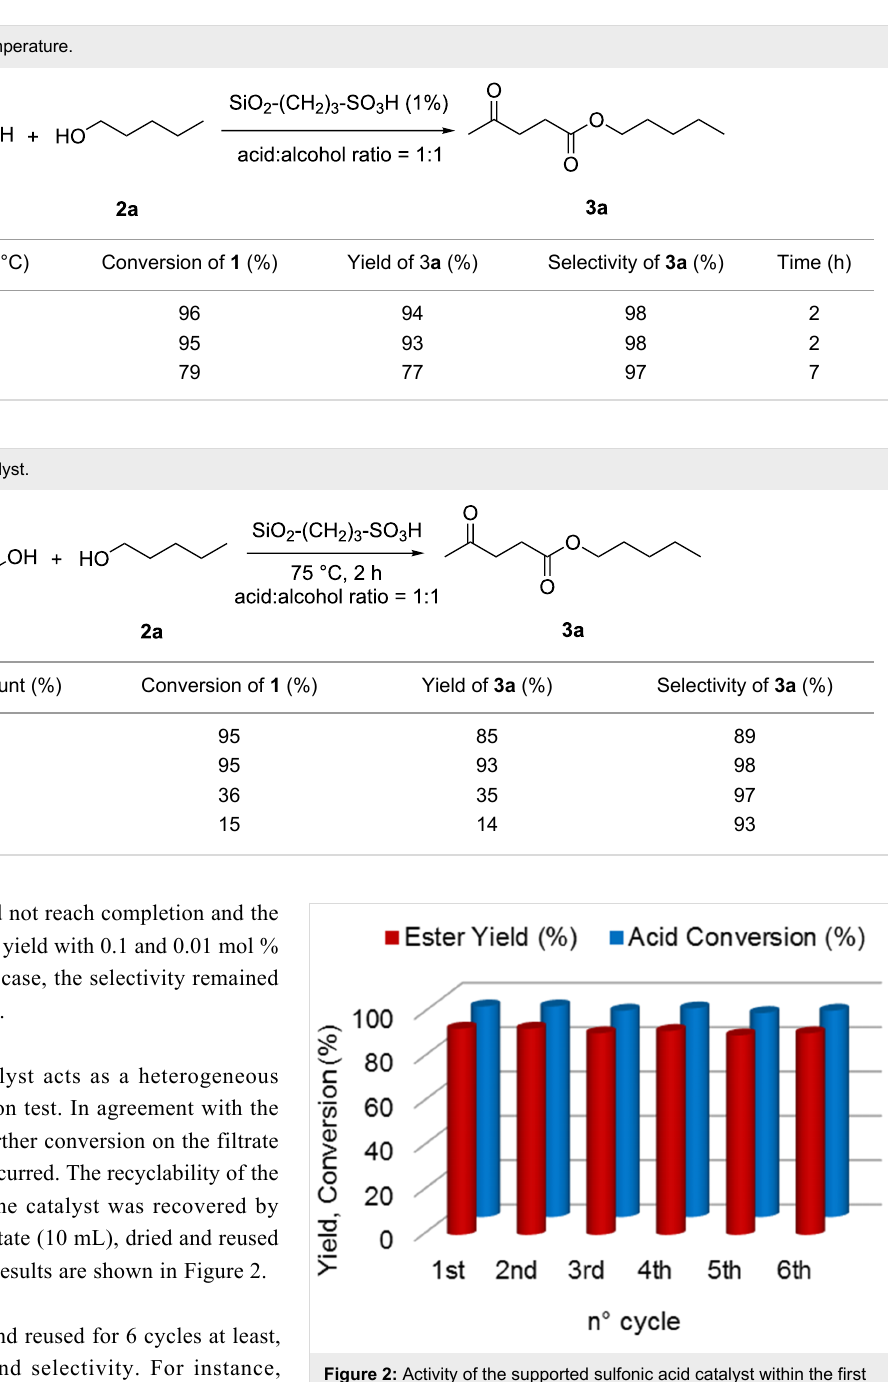
Figure 2: Activity of the supported sulfonic acid catalyst within the first six cycles. Reaction conditions: 1 mol % cat., acid:alcohol ratio = 1:1, solvent free, 75 °C, 2